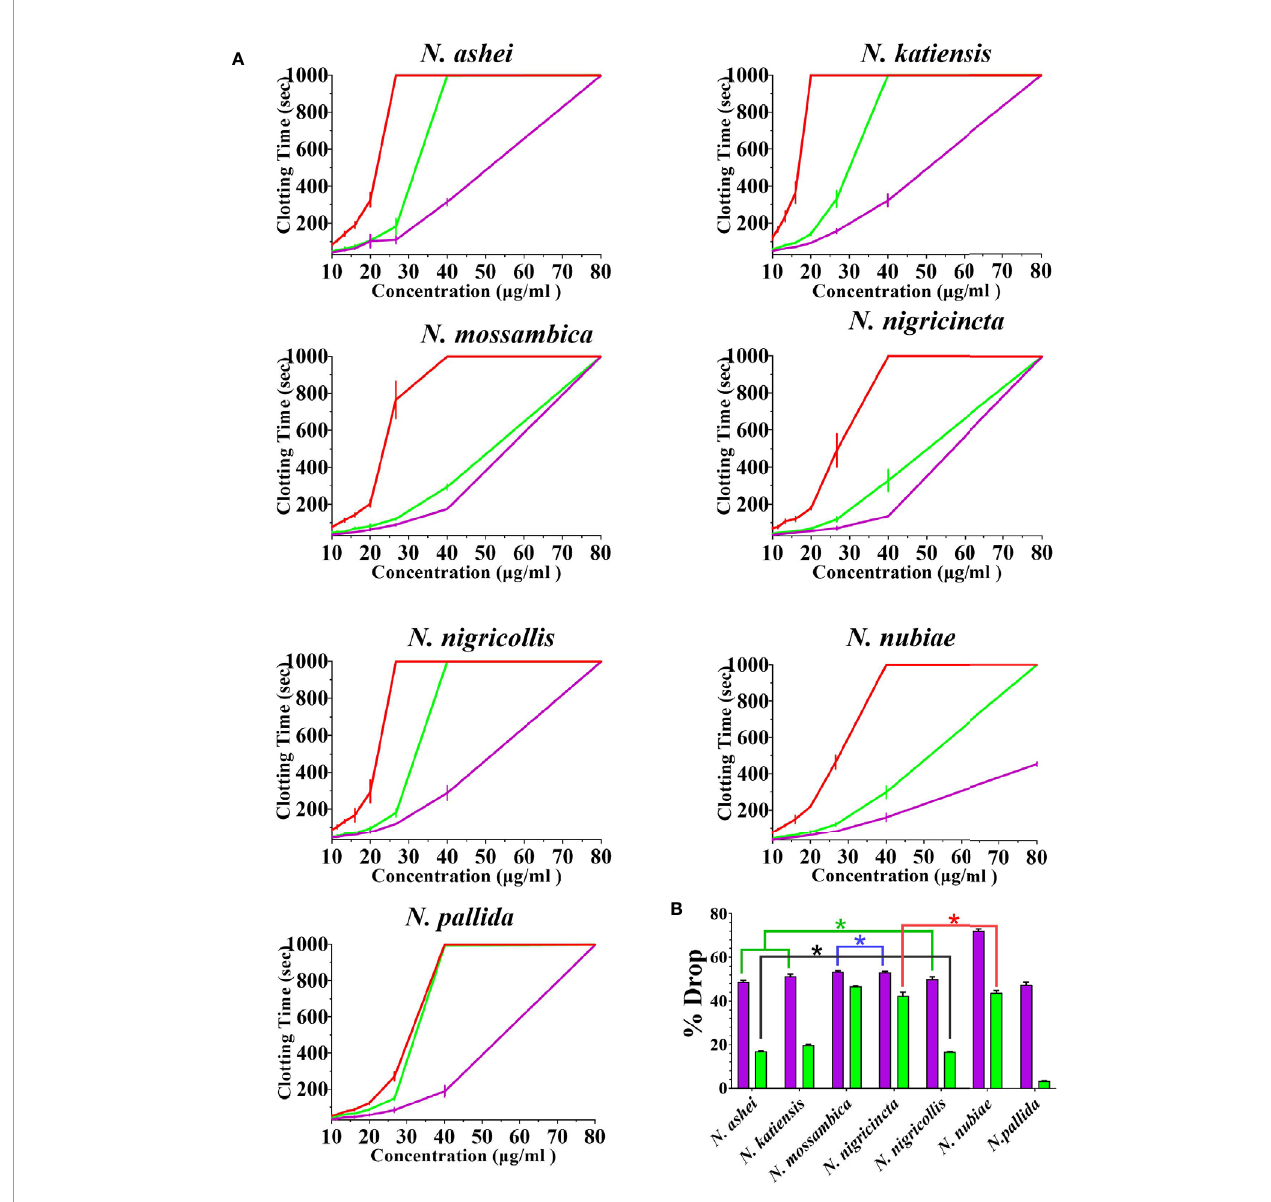
FIGURE 3 | The ability of the two metalloprotease inhibitors to inhibit FXa-binding anticoagulant toxicity (A) 8-point concentration curves with venom-induced clotting times shown as red curves, effect of venoms after pre-incubation with prinomastat as purple curves, and effect of venoms after pre-incubation with marimastat as green curves. Values are mean ± SD of N = 3 and shown as dots with error bars. Some error bars are too small to see. (B) Bar graphs of percentage drop of plasma clotting time due to induction of prinomastat and marimastat, with prinomastat as purple bars, marimastat as green bars. Values are mean ± SD of N = 3. * Represents no statistical signi fi cance ( p > 0.005) in percentage drops in Tukey ’ s multiple comparisons test at 95.00% con fi dence